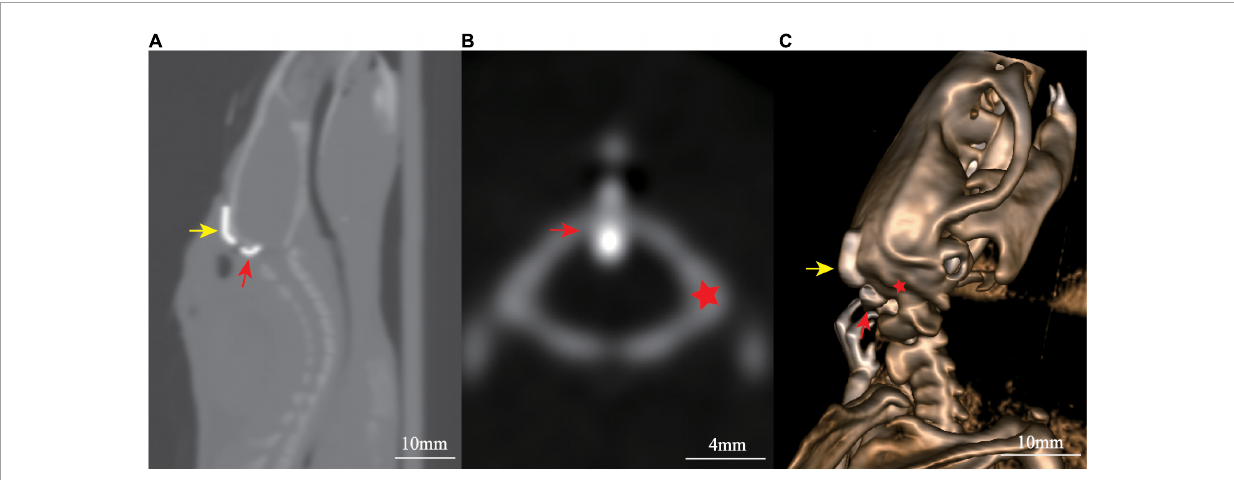
FIGURE3 Post-surgical computed tomography (CT) scan showed the localization of cannulation: (A) sagittal view, (B) axial view, and (C) three-dimensional reconstruction. Yellow arrow marks the fixing segment, while red arrow marks the puncture segment. The red star marks the occipital bone.